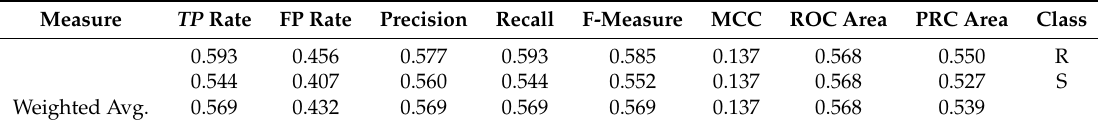
Table 2. Detailed accuracy by class of LIBLINEAR (10-fold